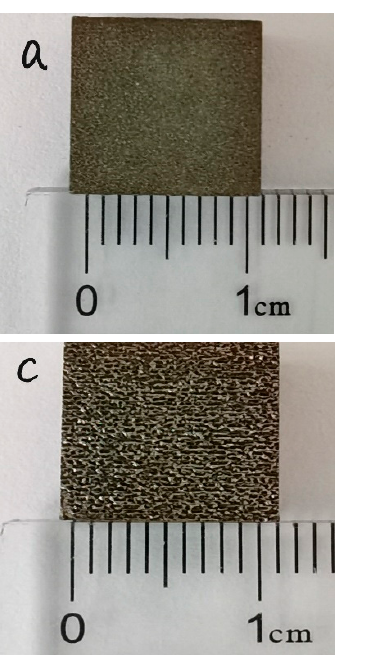
Figure 3. Crystallization of FAA before and after laser re-melting: ( a ) XRD pattern of raw powder; ( b ) XRD pattern of coating re-melted by lasers with different ° of power; ( c ) amorphous content of different coatings.